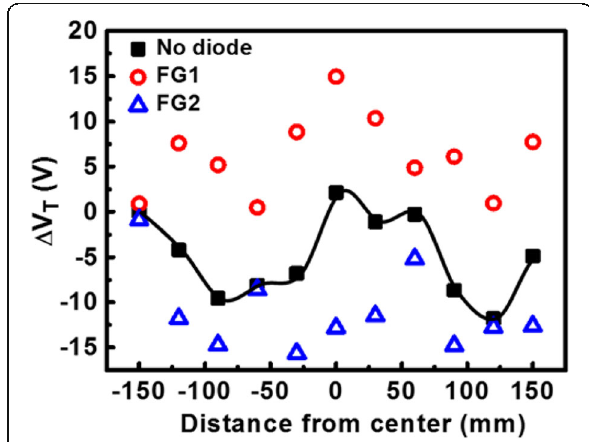
Fig. 6 Distribution of delta V T on FG 1 with forward diode and FG 2 with reverse diode, and FG without diode along the center line of